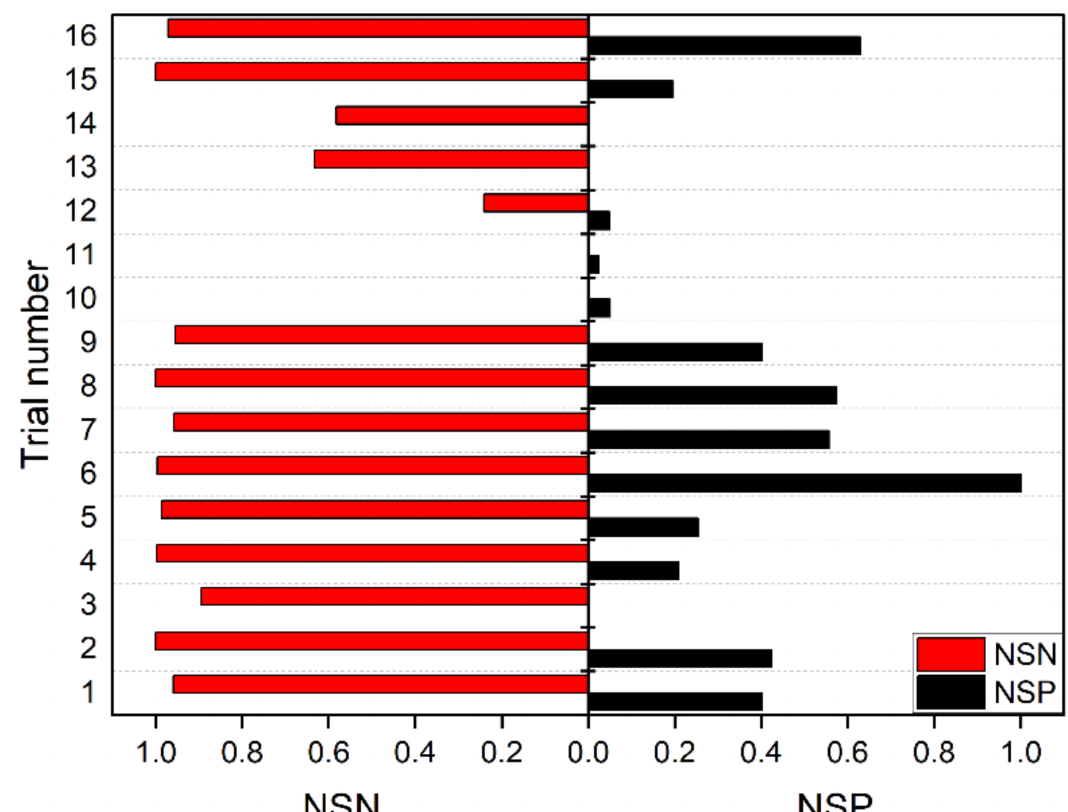
Figure 5. NSN and NSP values in EDAS method for case study